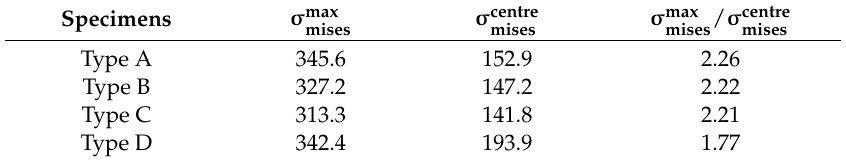
Table 2. The σ max , σ centre and σ max / σ centre of type A, B, C, and D specimens ( n = 1, σ 0 = 200 mises mises mises